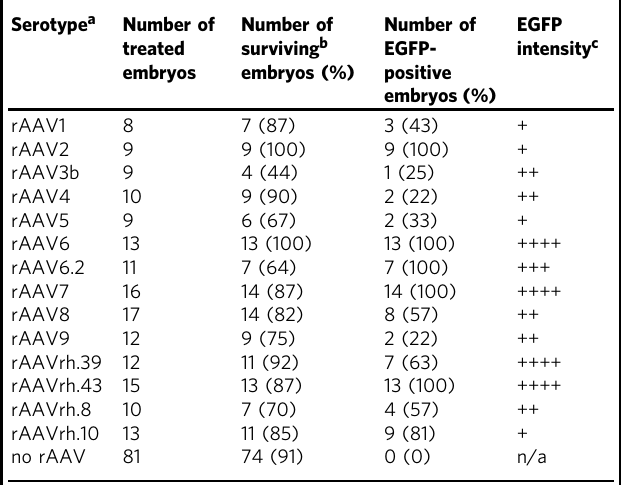
Table 1 Analysis of multiple rAAV serotypes for transduction of morulae ex